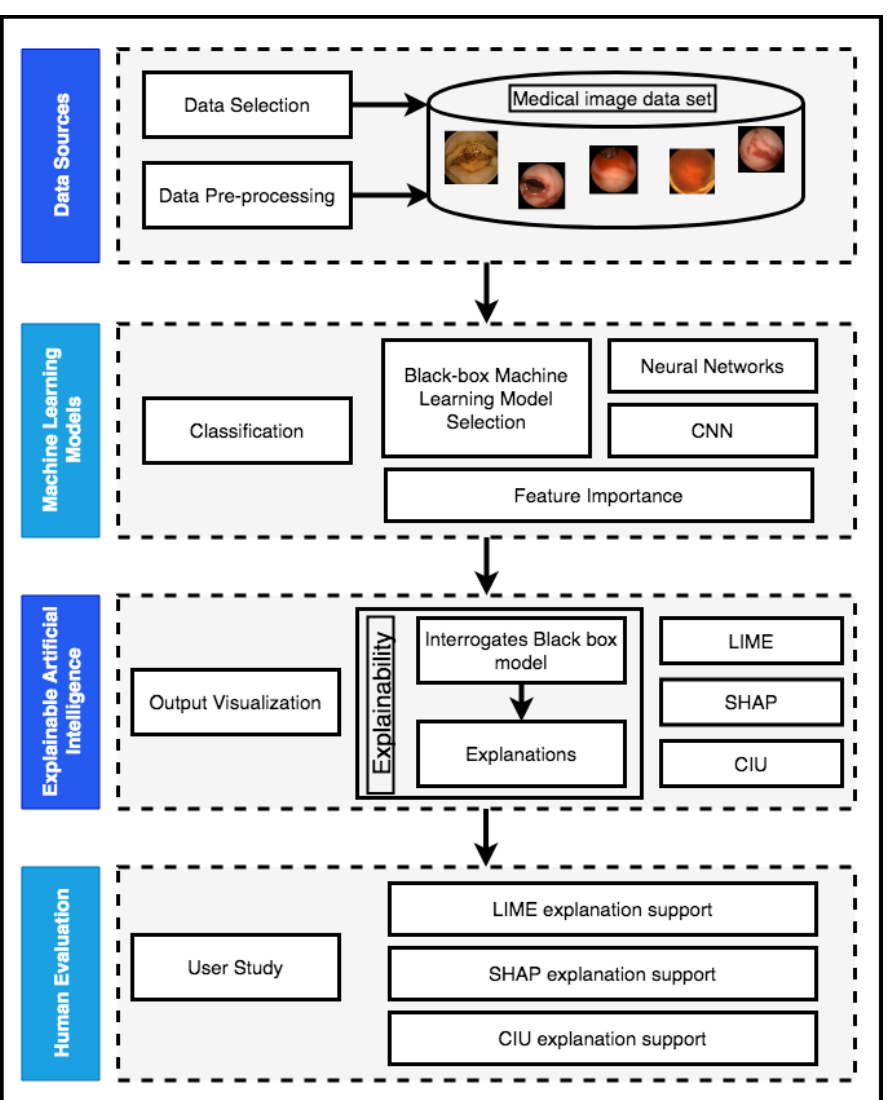
Figure 6. Workflow of the proposed